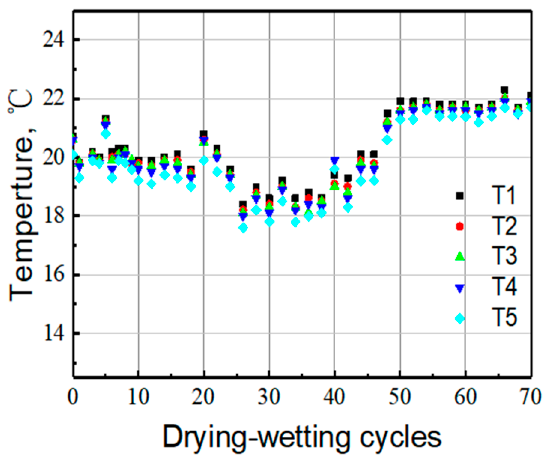
Figure 7. Temperature evolution with the development of dry-wet cycles by the humidity sensor in mortar sample.